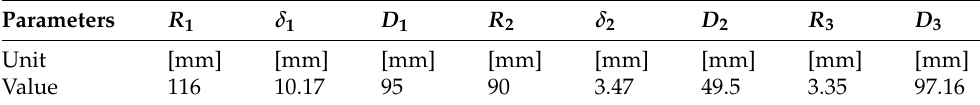
Table 1. The geometrical parameter values of the